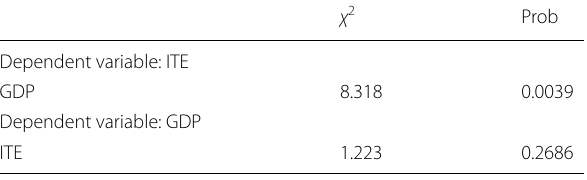
Table 9 Breitung and Candelon spectral density causality ( p